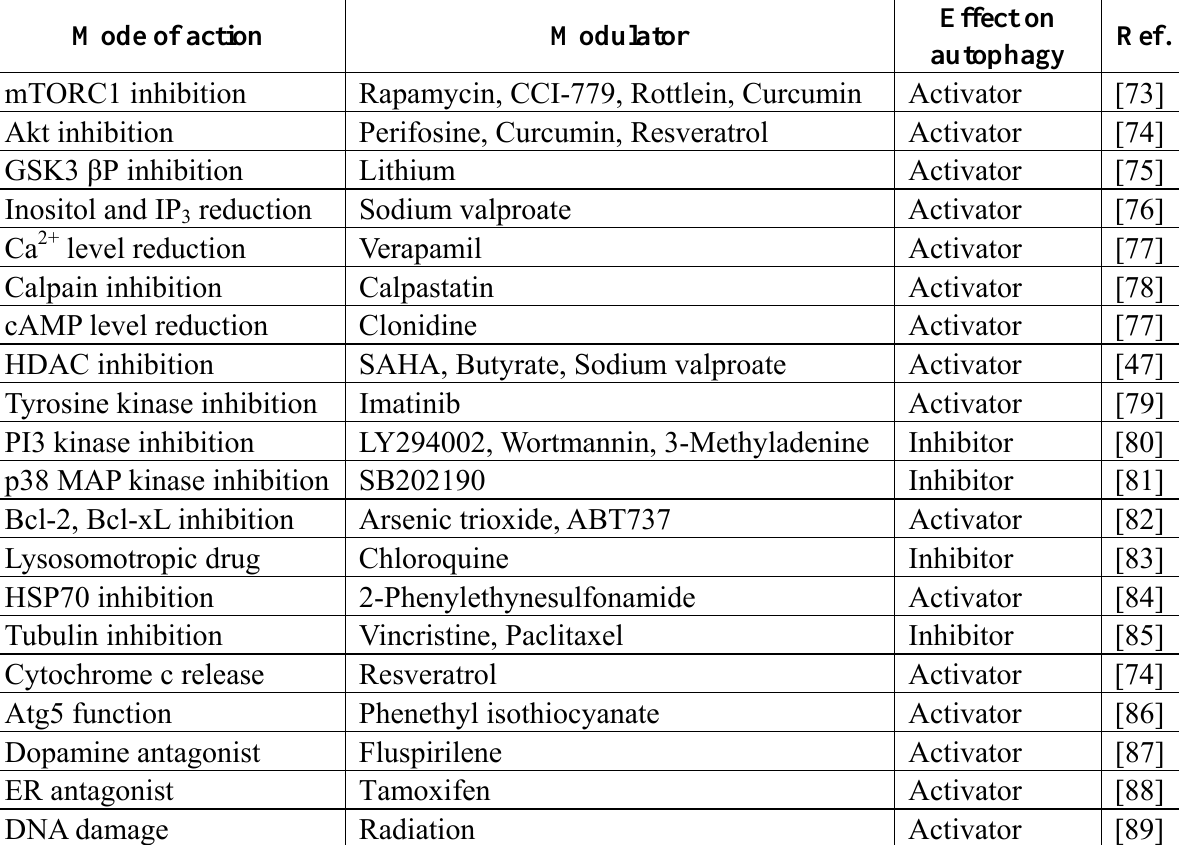
Table 3. Autophagy modulators and their mode of